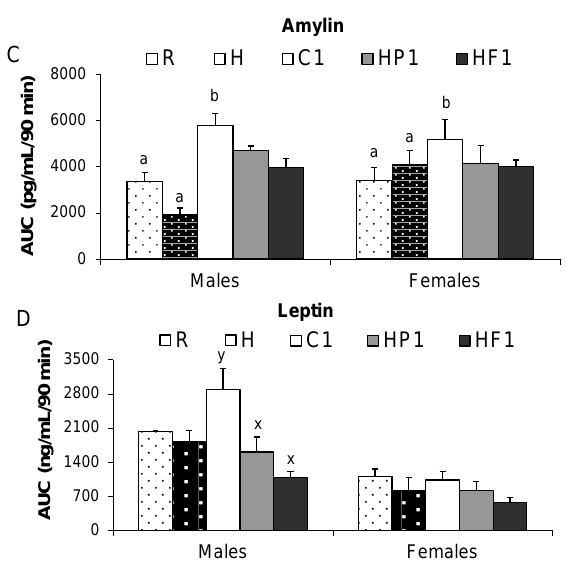
Figure 4. Area under the curve for glucose ( A ), insulin ( B ), amylin ( C ) and leptin ( D ) over a 90 min oral glucose tolerance test (OGTT) at 28 weeks. Values are means ± SEM, n = 10 per group except n = 4 for group H. Treatments with different letters are significantly different between diets: superscripts x,y indicate significant difference between C1, HP1, HF1; superscripts a,b indicate significant difference between R, H and C1 ( p < 0.05).